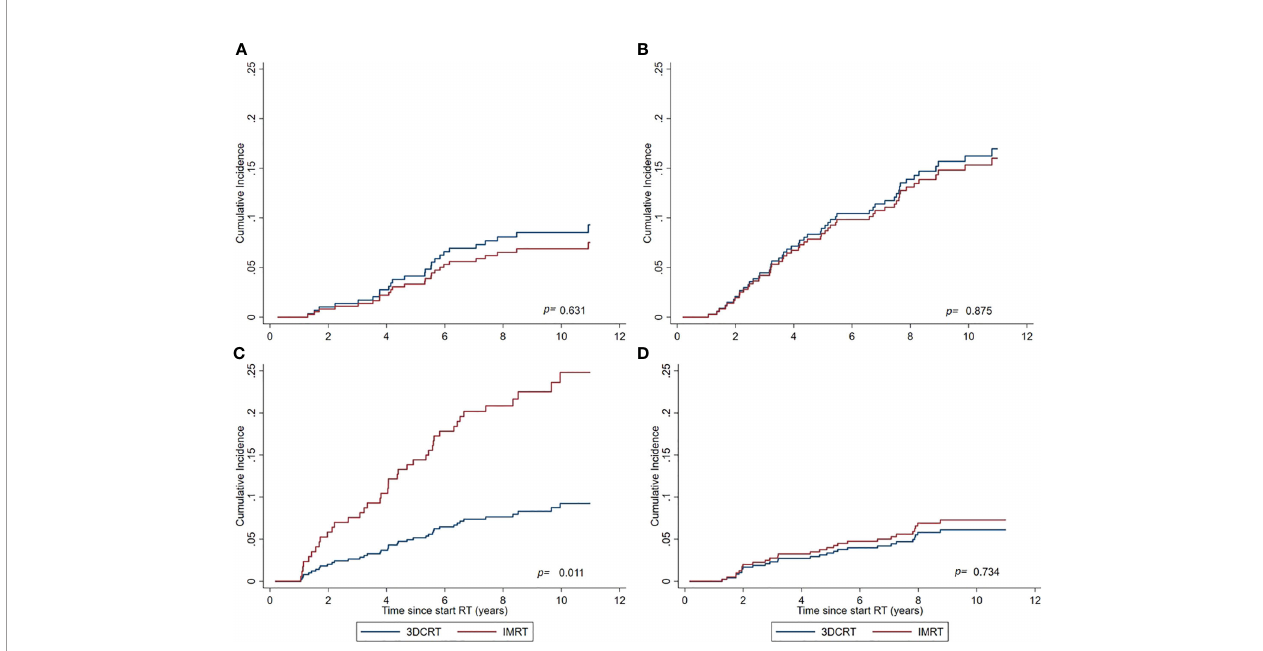
FIGURE 3 | Cumulative Incidence of non-pelvic SPCs for IMRT and 3DCRT subgroups, as estimated by the Fine and Gray model adjusted for calendar period and age. (A) Never smokers. (B) Previous smokers at time of treatment. (C) Active smokers at time of treatment. (D) Smoking status not reported in patient fi